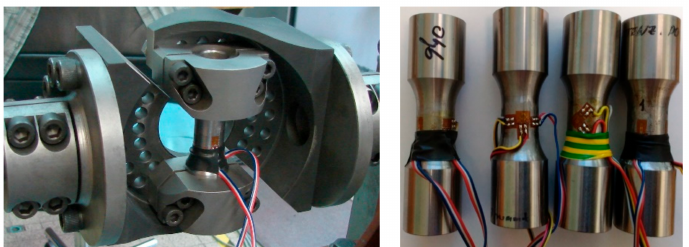
Figure 5. Examples of the load setup validations taken to ensure the applied stress are conforming to the